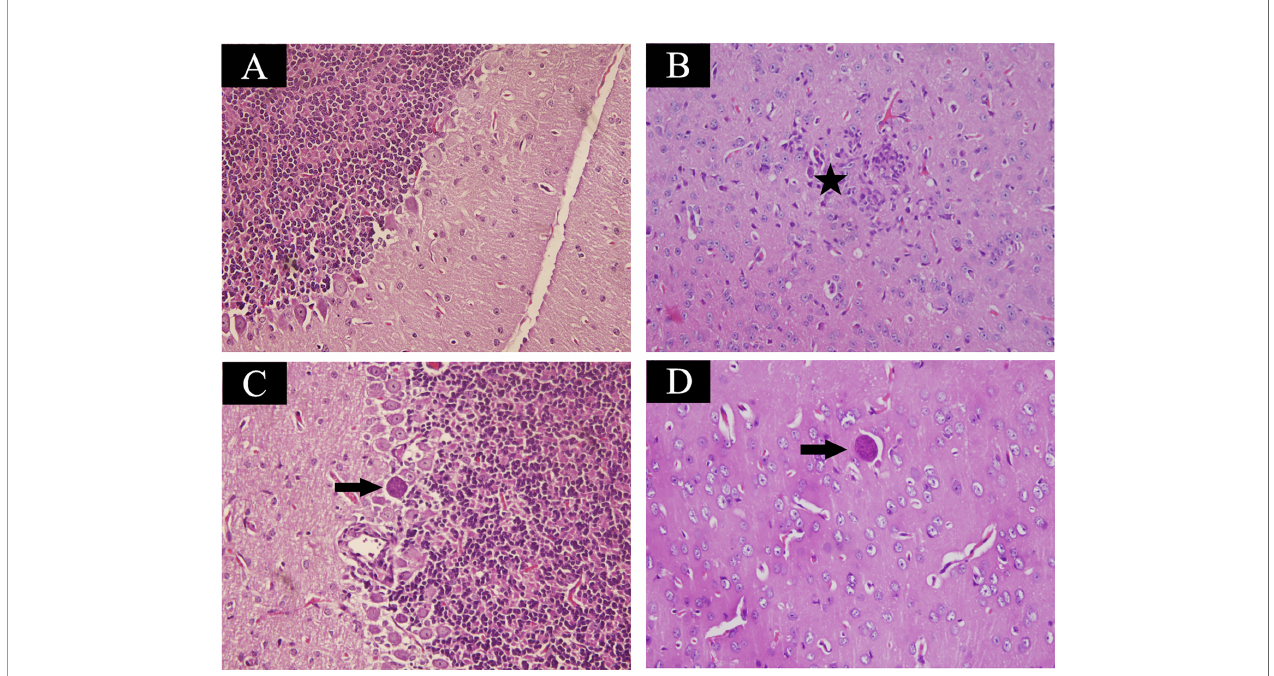
FIGURE 1 | Histopathological lesions in mouse brain infected with Toxoplasma gondii Pru strain (10 cysts per mouse by oral route, H&E stain). (A) Brain histology of control mice without any pathological changes. (B) A section of brain from acutely infected mice. Pentagram indicates in fl ammatory cell in fi ltration. (C, D) Brain histology of infected mice at chronic infection phase. Arrow indicates the tissue cyst. Magni fi cation